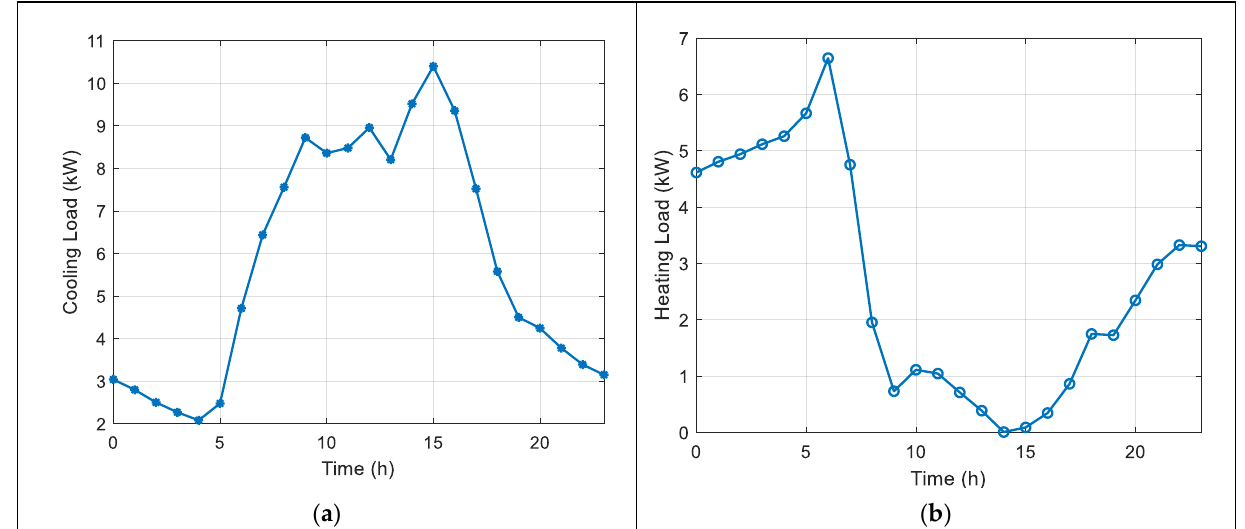
Figure 3. Weather Data for Melbourne, FL, USA: ( a ) ambient temperature; ( b ) solar irradiation.